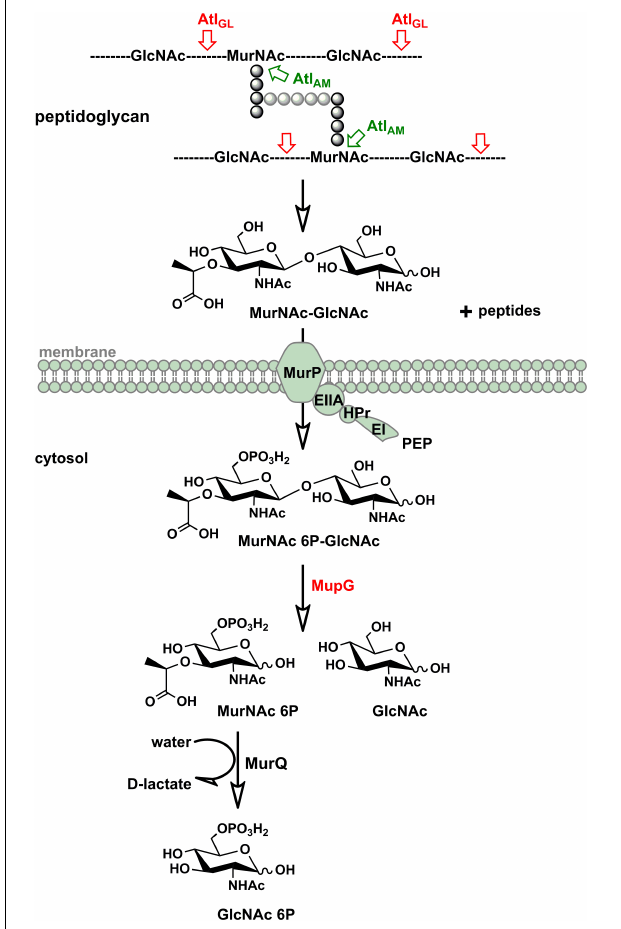
FIGURE 7 | Scheme of the peptidoglycan sugar recycling in S. aureus . During growth and division, S. aureus cells constantly degrade and resynthesize their peptidoglycan. The major autolysin Atl, a bifunctional muramoyl- L -alanine amidase and endo- N -acetylglucosaminidase, is able to cleave its peptidoglycan, generating MurNAc-GlcNAc and peptide turnover products. MurNAc-GlcNAc disaccharide is reutilized: transported in the cells and concommitantly phosphorylated by the MurP PTS transporter generating intracellularly MurNAc 6P-GlcNAc. Subsequently, the MurNAc 6-phosphate-GlcNAc glycosidase MupG cleaves this compound, generating the products MurNAc 6P and GlcNAc. The D -lactyl ether substituent of MurNAc 6P is specifically cleaved off by the etherase MurQ, previously characterized in our lab, forming GlcNAc 6P and D -lactate (Borisova et